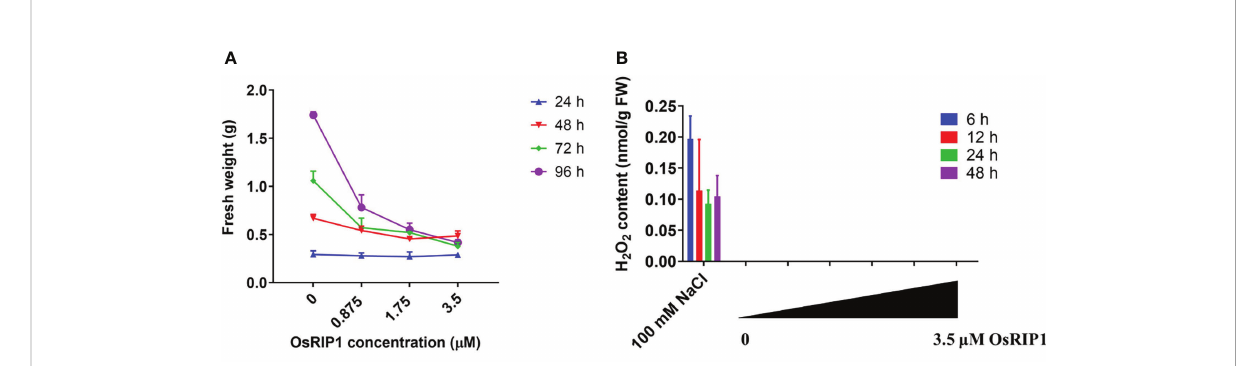
FIGURE 4 Responses of BY-2 cells to different concentrations of OsRIP1. (A) fresh weight of tobacco BY-2 cells harvested after treatment. (B) H 2 O 2 levels in BY-2 cells exposed to different concentrations of OsRIP1. BY-2 cells treated with 100 mM NaCl were used as positive controls for the H 2 O 2 determination assays. Four biological replicates and technical triplicates were performed for BY-2 cells treated in the absence (CTRL) or presence of OsRIP1 for desired incubation times. Data are expressed as mean ± standard deviation